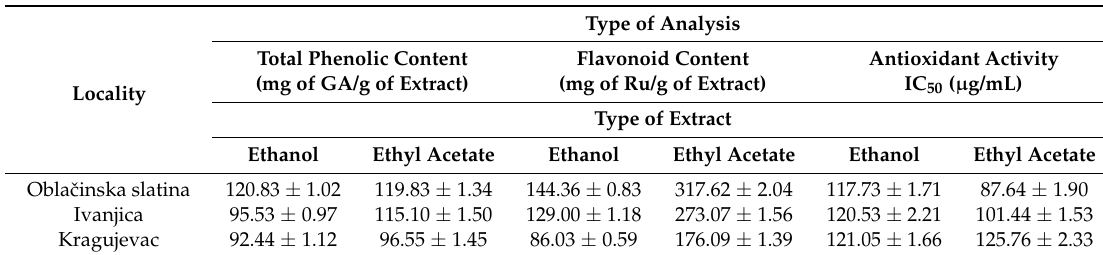
Table 1. Total phenolic content, flavonoid concentration, and antioxidant activity of the analysed species in ethanol and ethyl acetate